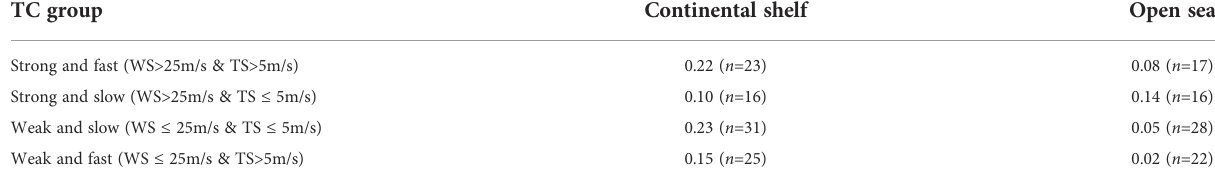
TABLE 2 TC-induced Chl_en (mg/m 3 ) of four groups categorized based on the average of TC wind speed (WS) and translation speed (TS).